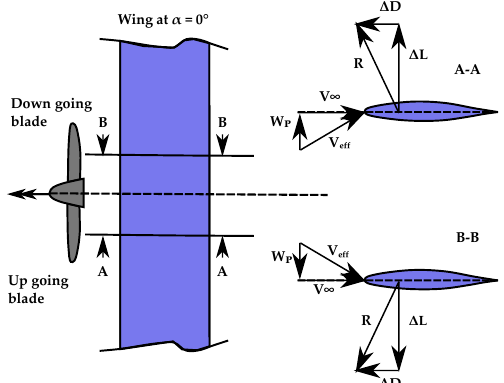
Figure 2. Local forces on a wing section inside the propeller slipstream: upwash region (section A-A) and downwash region (section